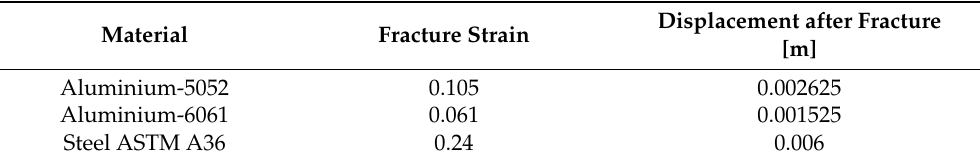
Table 2. Fracture values of the metals used in the paper as was done in